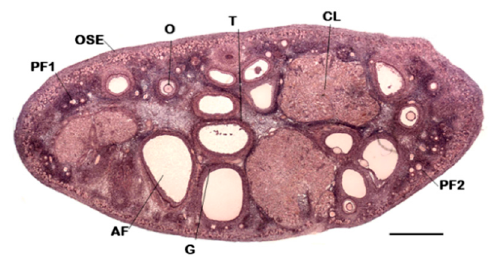
Figure 1. A mammalian ovary. Panoramic view of a mouse ovary by light microscopy. Follicles at various stages of development are shown. Follicles become responsive to FSH from the secondary stage onward. In these follicles, estrogen production increases. Mid-cycle Luteinizing Hormone (LH) surge induces oocyte meiotic resumption and the ovulated oocyte is arrested at MII. The CL originates from cells of the follicle wall during ovulation, although its precise origin remains controversial. Abbreviations: PF1 (primordial follicle); PF2 (primary follicle); AF (antral follicle); O (oocyte); G (granulosa cells); T (theca cells); OSE (ovarian surface epithelium); CL (corpus luteum). Bar = 1